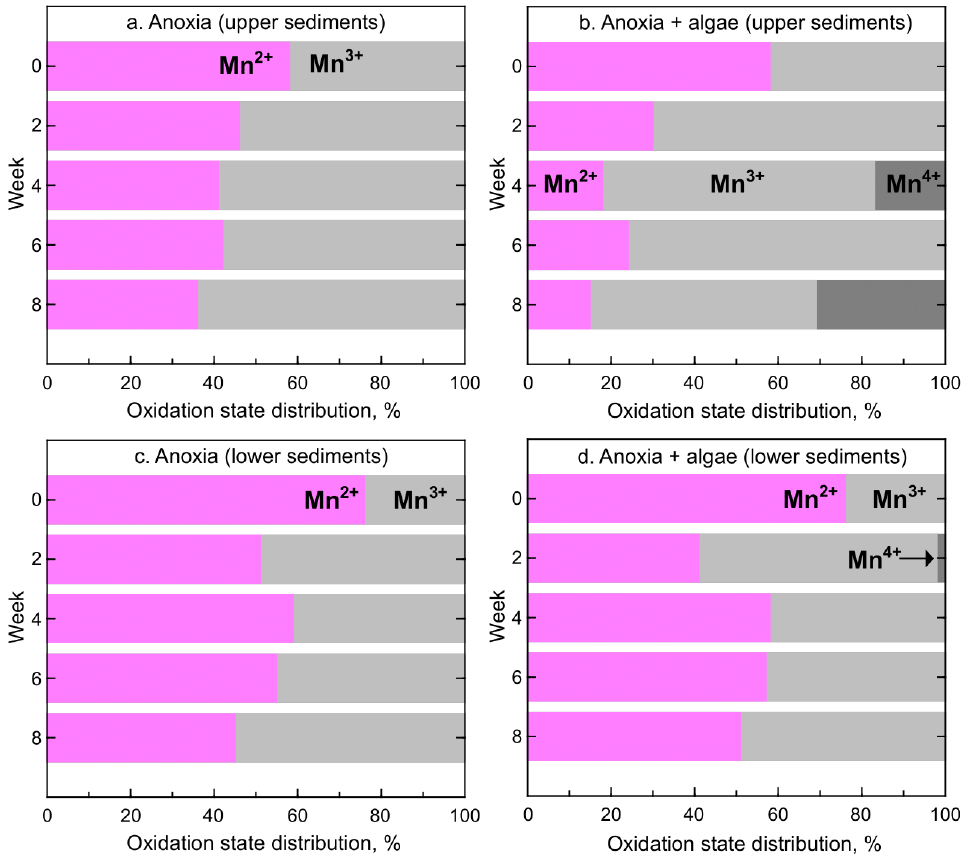
Figure 6. Distribution of manganese oxidation states in upper and lower sediment samples of the control (anoxia) and treatment (anoxia + algae) cores over the course of the 8-week experiment.